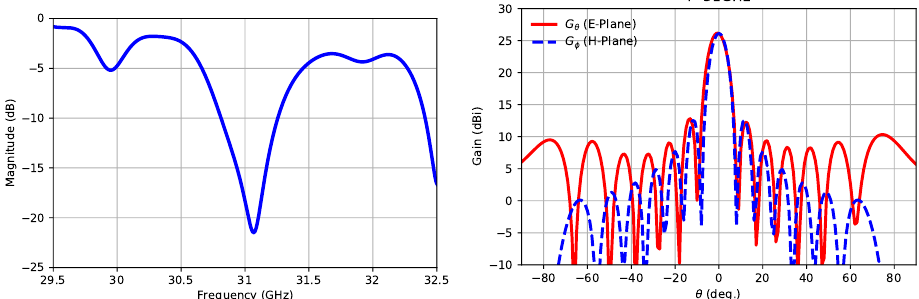
Figure 13. Simulated S 11 and gain radiation patterns for the antenna at 31